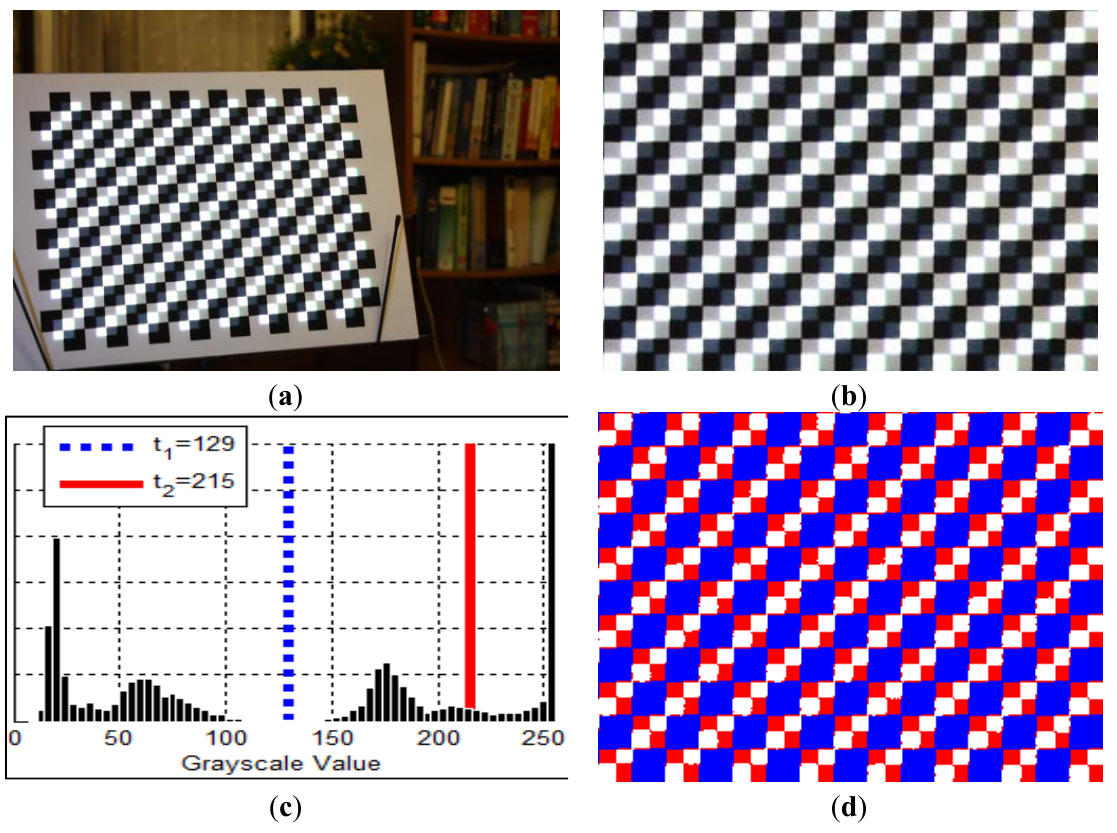
Figure 6. ( a ) Image of the checkerboard with projection of the generated calibration pattern. ( b ) Rectified region of interest. ( c ) Histogram and the optimally determined thresholds. ( d ) Classified pixels, blue, red, and white pixels represent “dark”, “gray” and “bright” categories